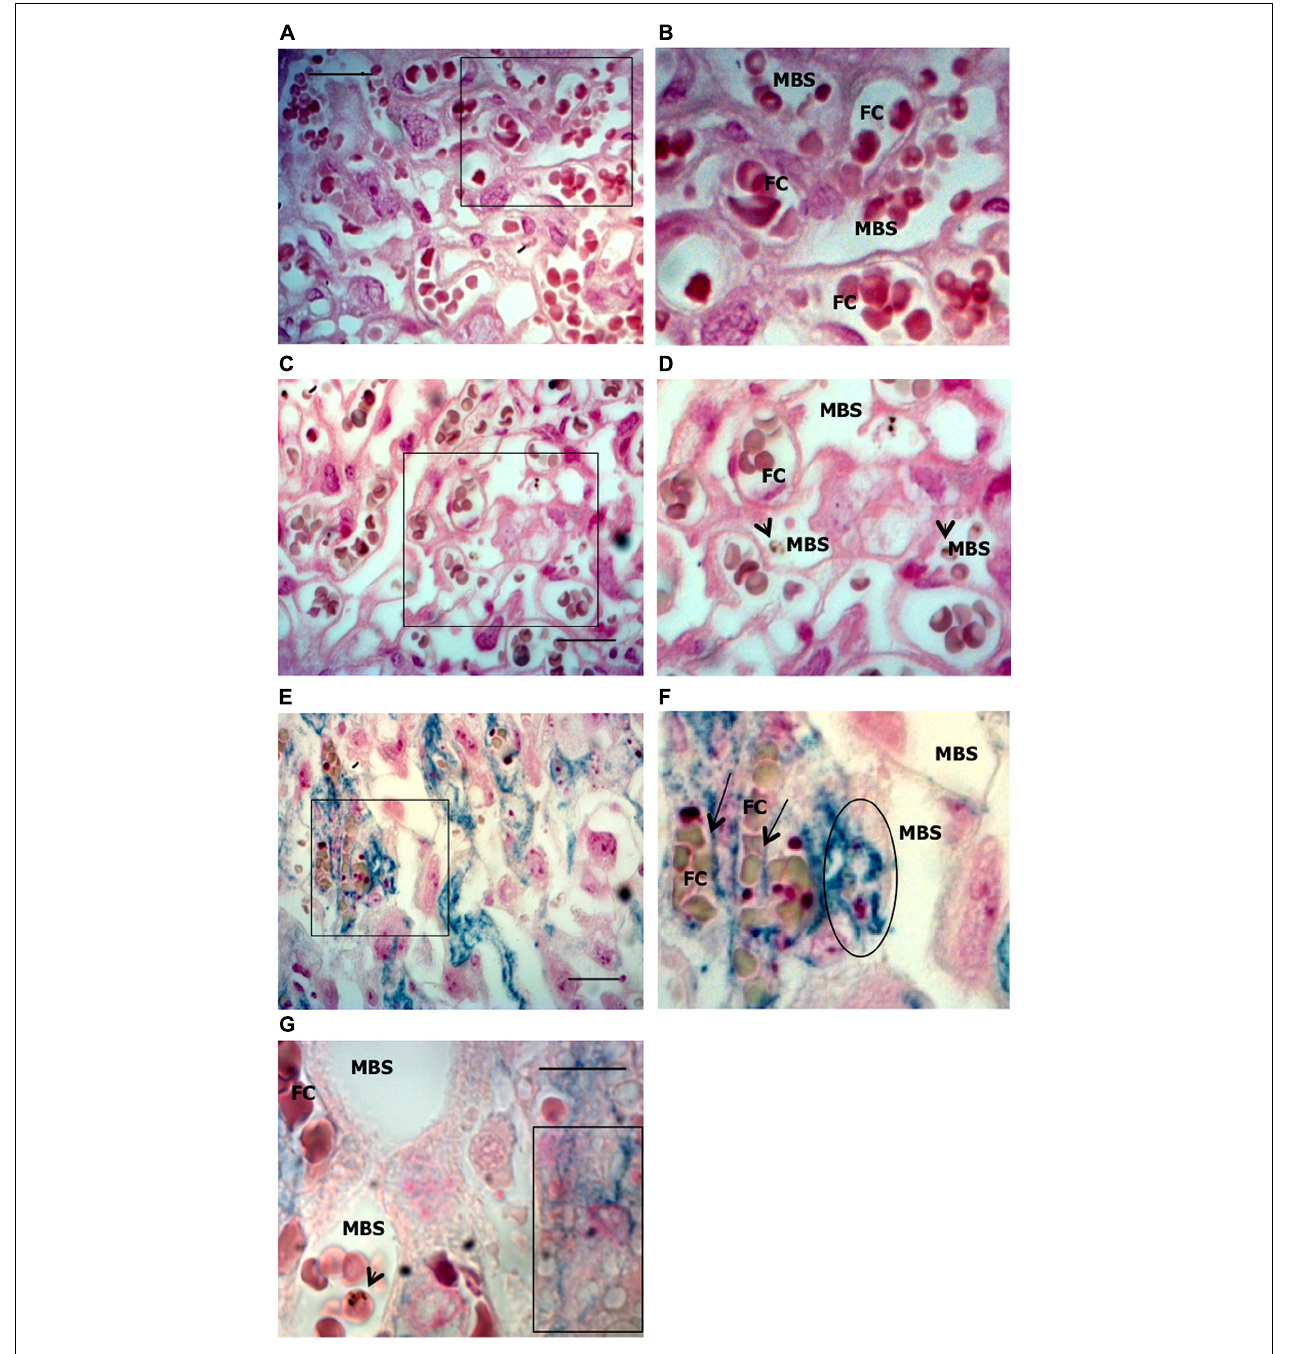
significant iron accumulation (blue) in trophoblast and loss of integrity of the tissue structure. Iron seems to be accumulated in phagocytic trophoblasts (surrounded area in F and box in G ) and at the interface between trophoblast and fetal capillary (arrows in F ) but not in MBS (E–G) . Areas delimitated in A , C , E are magnified (crop and zoom) in B , D , F, respectively. Scale bars: 25 μ m (A , C , E) and 10 μ m (G) . Arrowheads point to infected